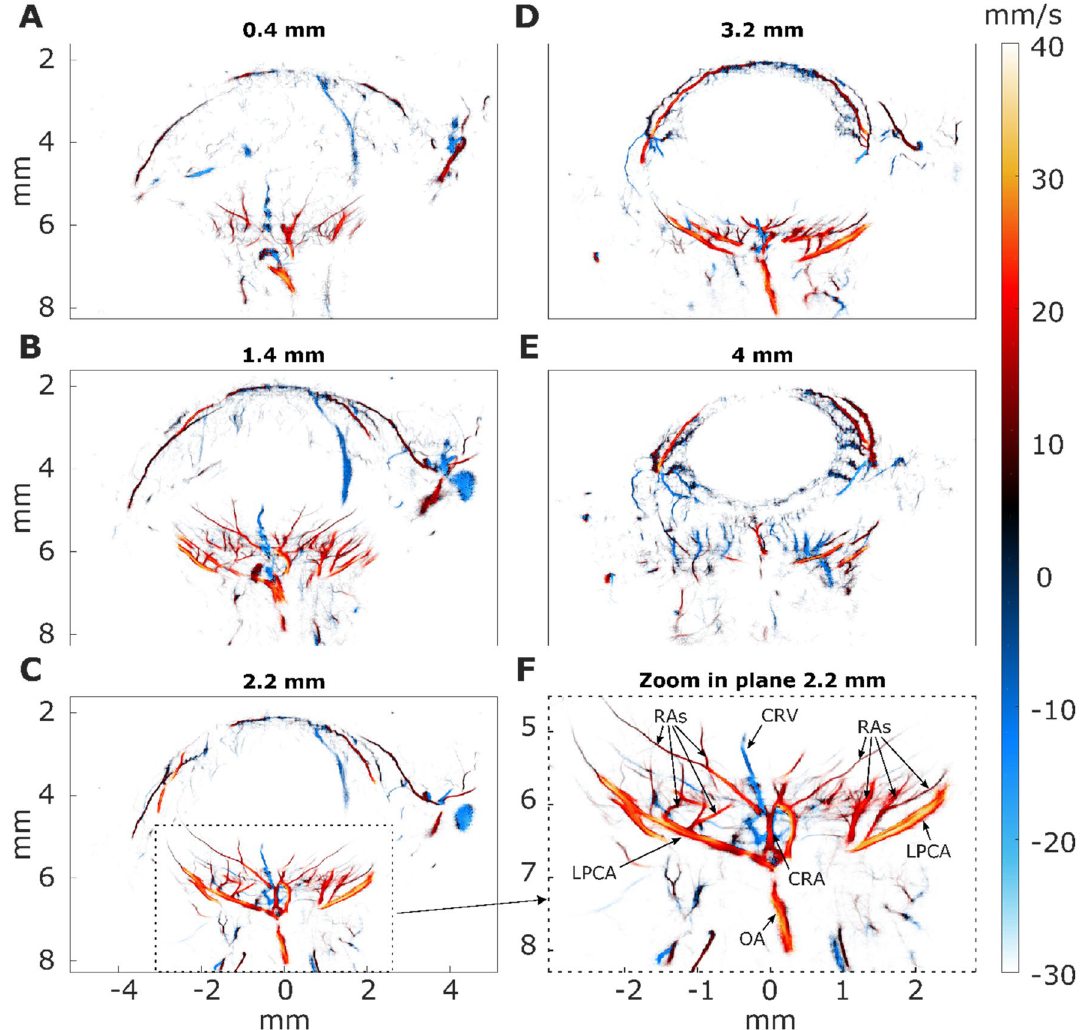
Figure 2. Super-resolution imaging reveals the vascular anatomy of the rat eye. Intravenous injection of microbubbles increases the resolution from approximately 100 microns to approximately 15 microns. Twenty-three planes were acquired every 200 µm in the anteroposterior direction. 5 out of the 23 ULM planes are displayed, ( A ) plane 10, ( B ) plane 15, ( C ) plane 17, ( D ) plane 20, ( E ) plane 23. ( F ) Zoom in the retinal microvasculature. The retina is perfused by the central retinal artery (CRA), which enters the retina at the optic disk, traveling through the optic canal alongside the optic nerve. The CRA and long posterior ciliary arteries (LPCAs) arise from the ophthalmic artery (OA), the first major branch of the internal carotid artery. Along its course, the CRA gives off radial arterioles (RAs) and smaller vessels on the vitreal surface of the retina. Blood returns through radial venules on the retinal surface that empty into the central retinal vein (CRV) in the optic